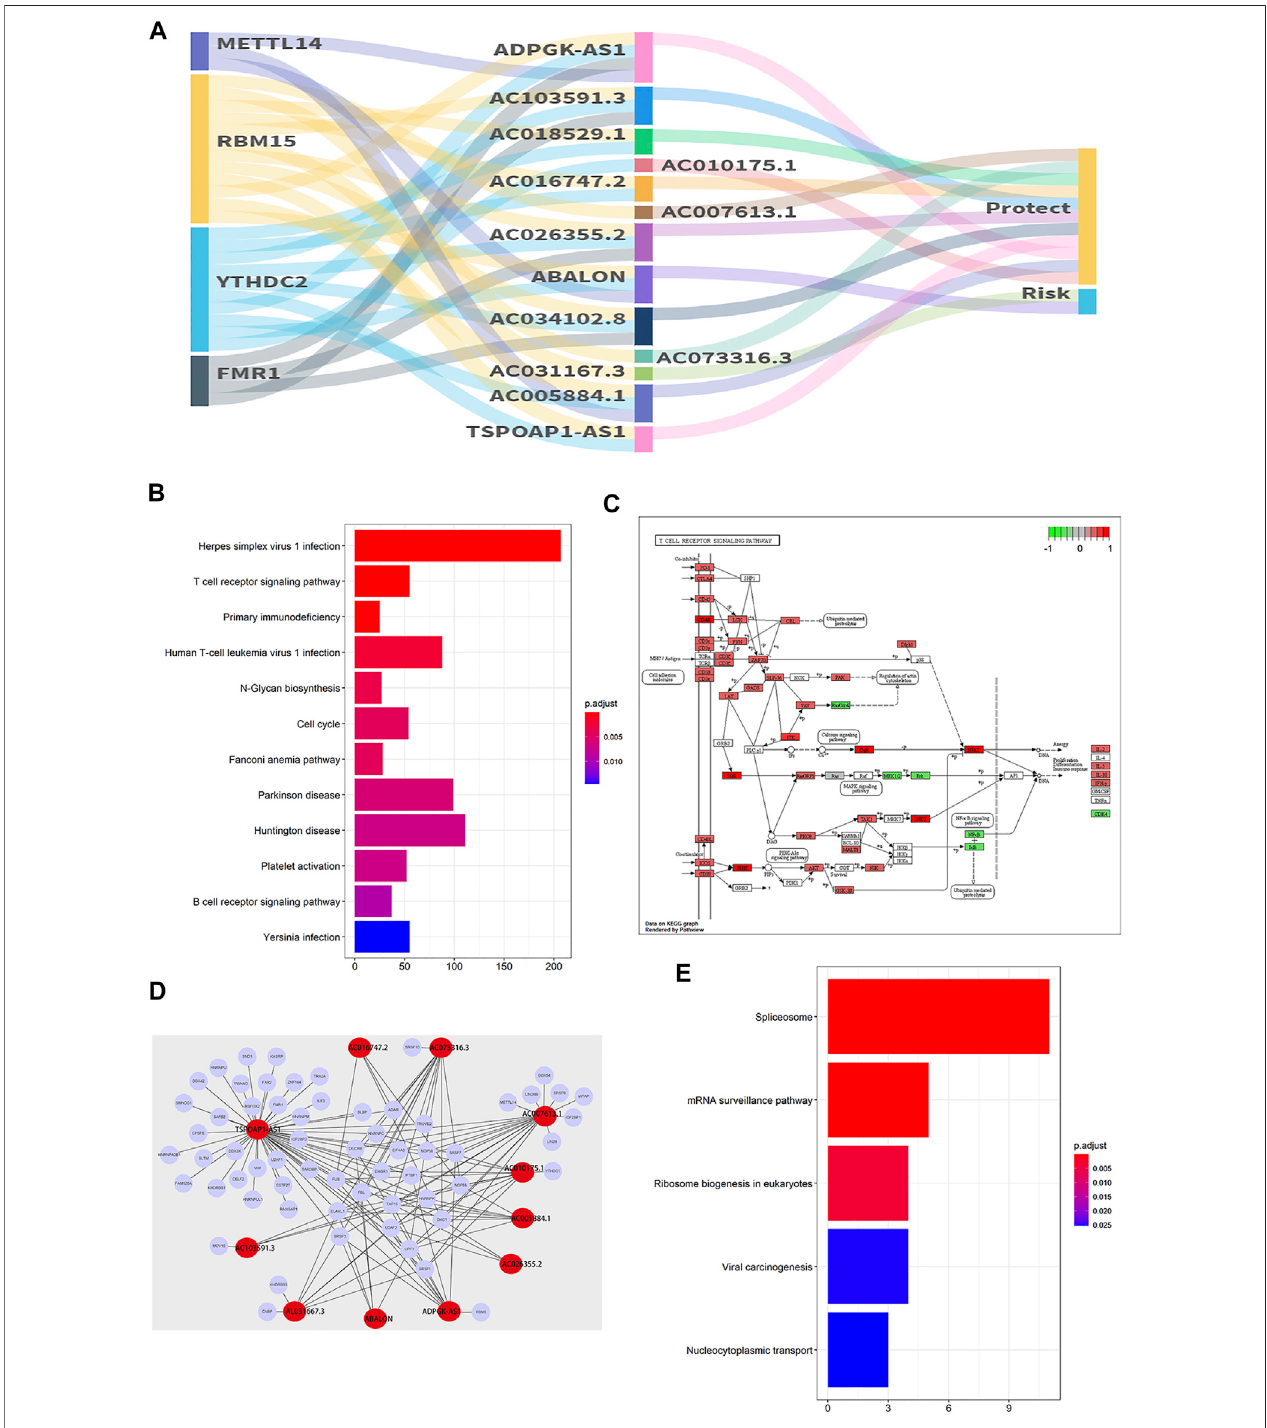
FIGURE 12 | The co-expression network and gene enrichment analysis. (A) The constructed m6A-related prognostic lncRNAs and m6A genes co-expression networkwasvisualizedusingtheSankeydiagram. (B) KEGGanalysisoftargetgenes(basedonco-expression)of13m6A-relatedlncRNAs. (C) ThepathwayoftheTcell receptor signaling pathway (hsa04660). (D) The network is based on 13 prognostic m6A-related lncRNAs and the potential target genes identi fi ed by the RNA binding protein (RBP)-lncRNA module in Starbase. (E) KEGG analysis of 134 potential target genes (based on Starbase database) of 13 m6A-related lncRNAs.